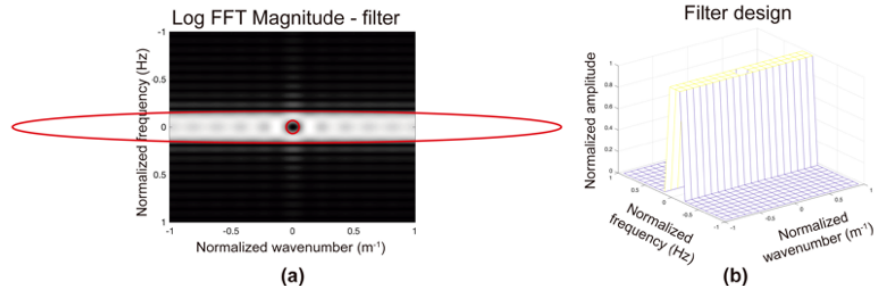
Figure 4. ( a ) Magnitude spectrum with the elliptical red lines corresponding to the filter design. ( b ) Filter design of this dataset. This bandpass filter has unit value in the area to be maintained